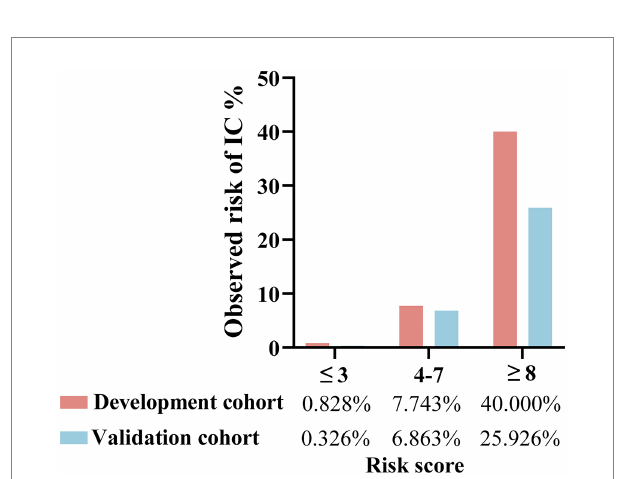
FIGURE 7 Risk groups according to risk score of the predictive scoring system and observed risk of IC in the development and validation